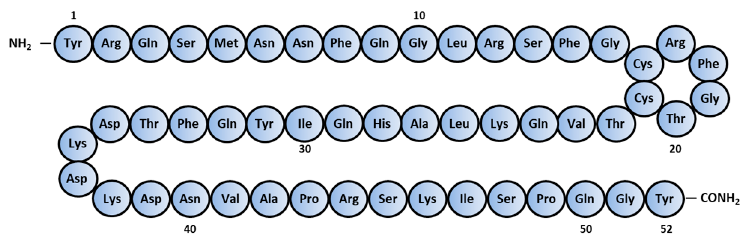
Figure 1. Amino-acid sequence of human Adrenomedullin.